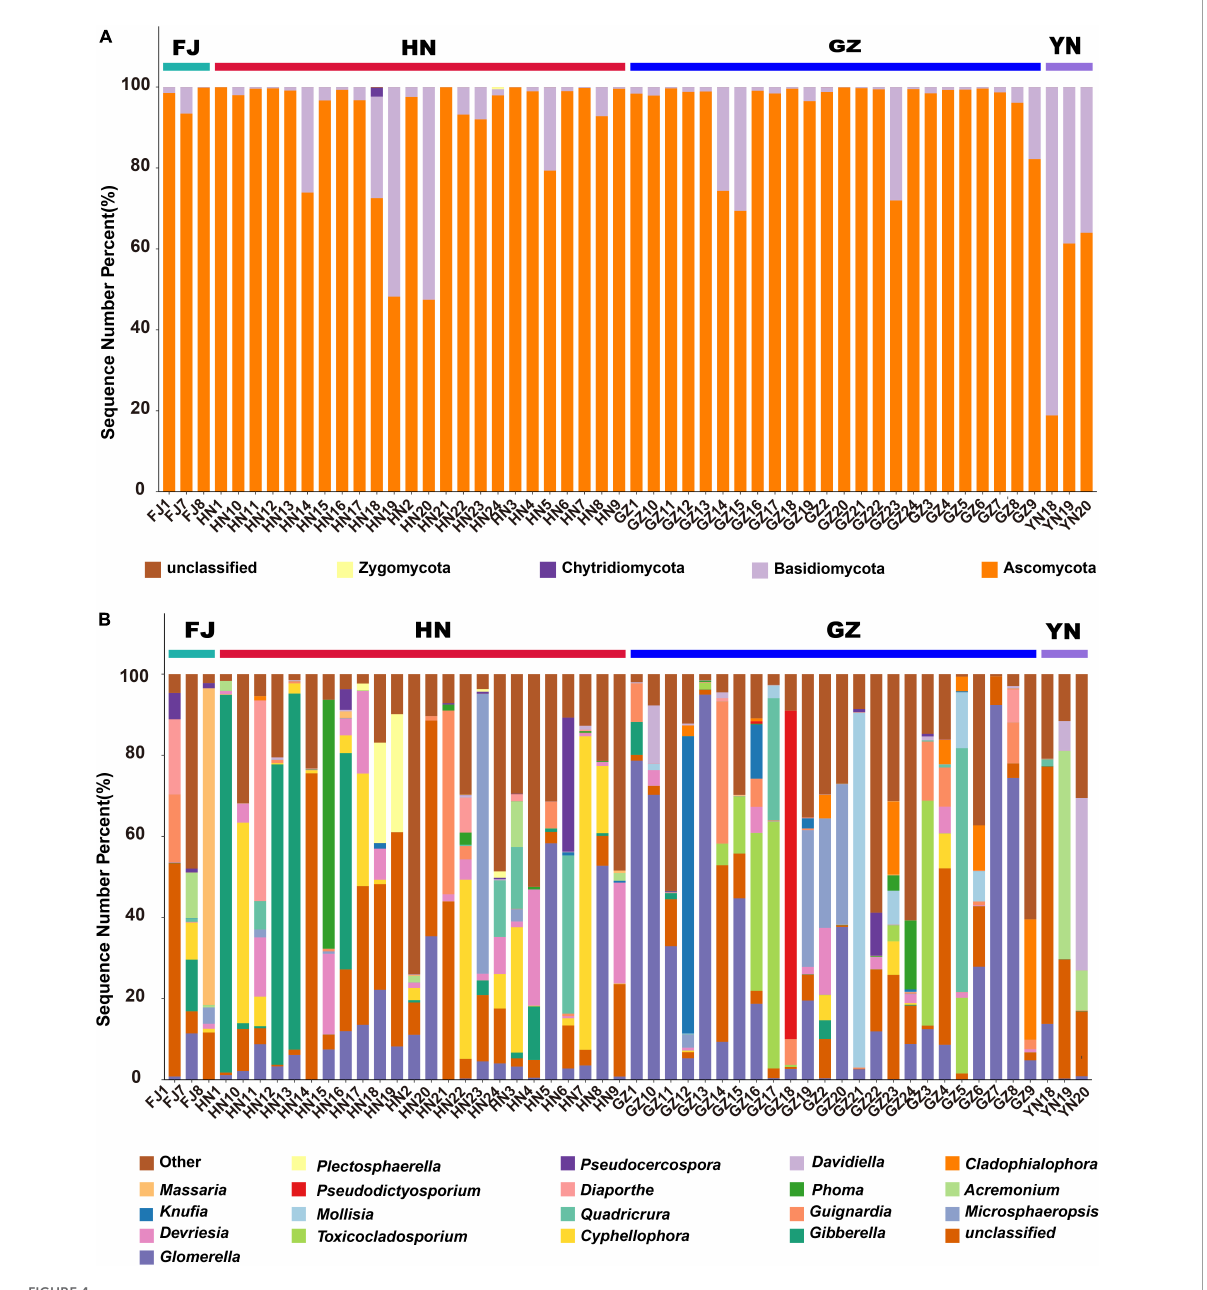
FIGURE4 The endophytic fungal community composition of Dendrobium nobile from different habitats at the phylum (A) and genus (B)